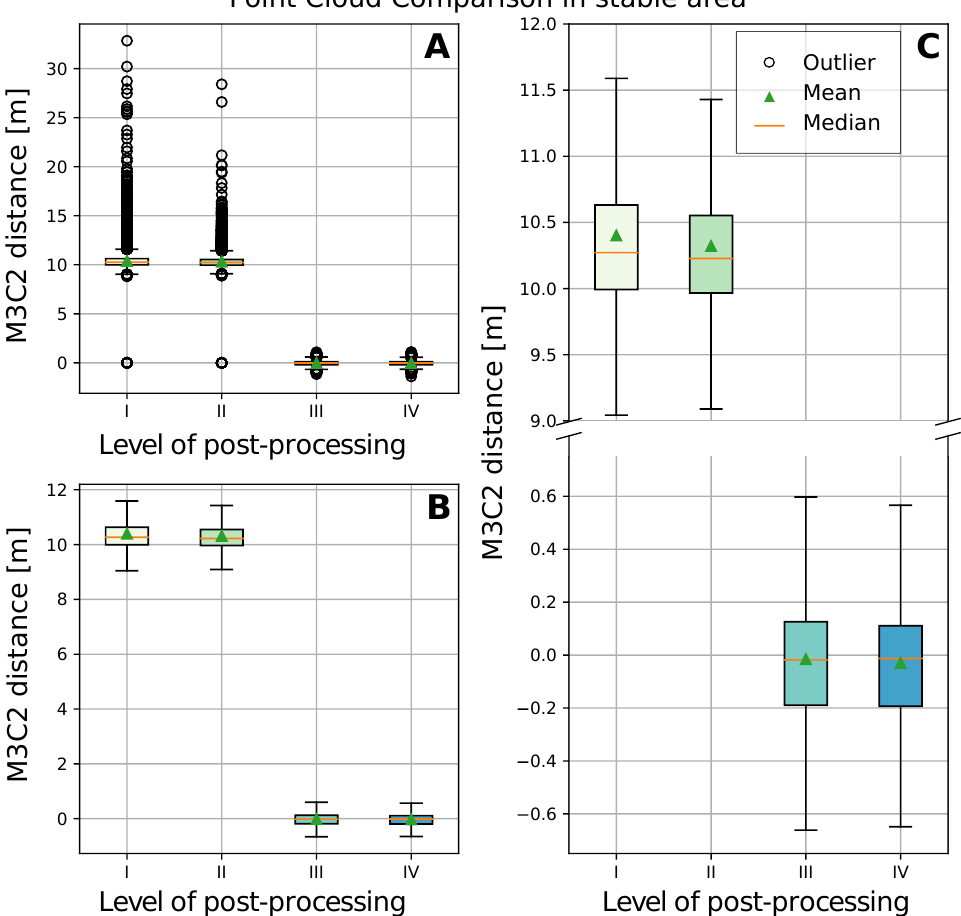
Figure 5. Cloud distances derived via Multiscale Model to Model Cloud Comparison (M3C2) in the point cloud subset of the stable area at the junction of the Dalton Highway. Results are grouped according to the levels of post-processing (I) raw, (II) denoised (III) denoised + ICP aligned, (IV) denoised + AROSICS shifted + ICP aligned data. Boxplots (25% and 75% percentile) ( A ) with and ( B ) without outliers and ( C ) close-up on median, mean and percentile